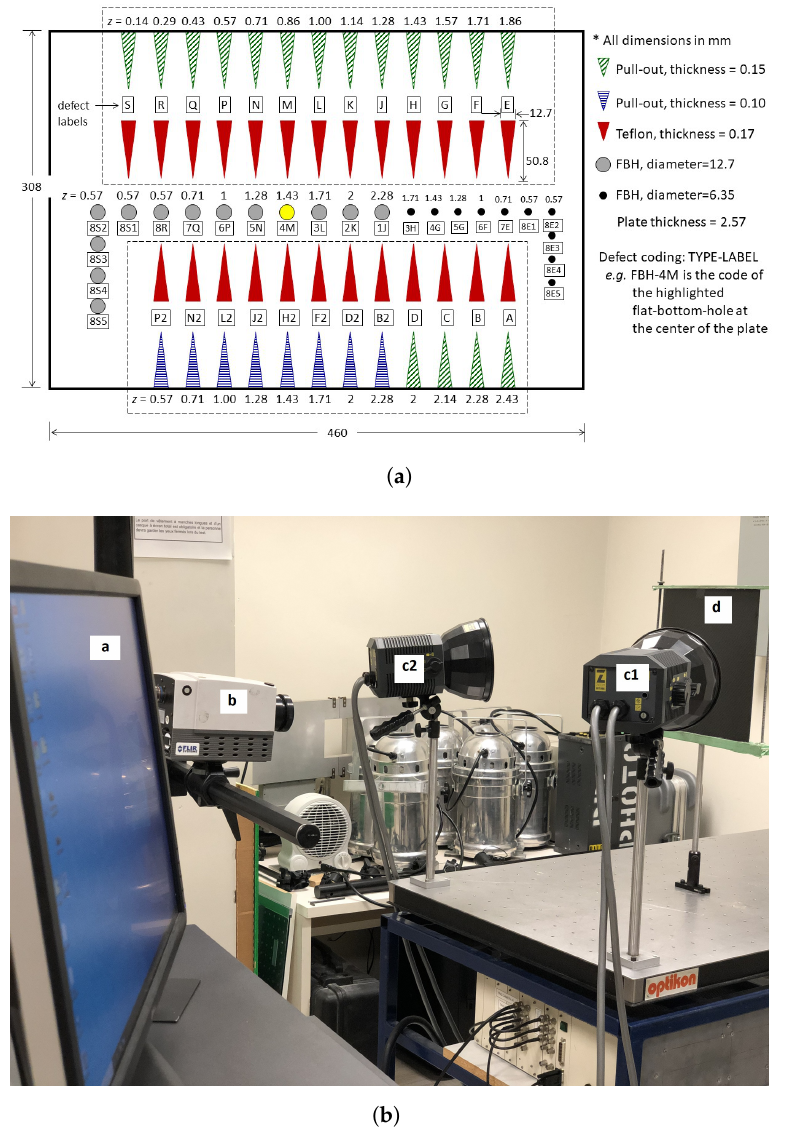
Figure 2. ( a ) CTA CFRP plate, where Z is the defect depth and labels are used to identify the location of each defect; and ( b ) pulsed thermography setup. a, PC; b, IR camera; c1 and c2, left and right flashes; d, CFRP